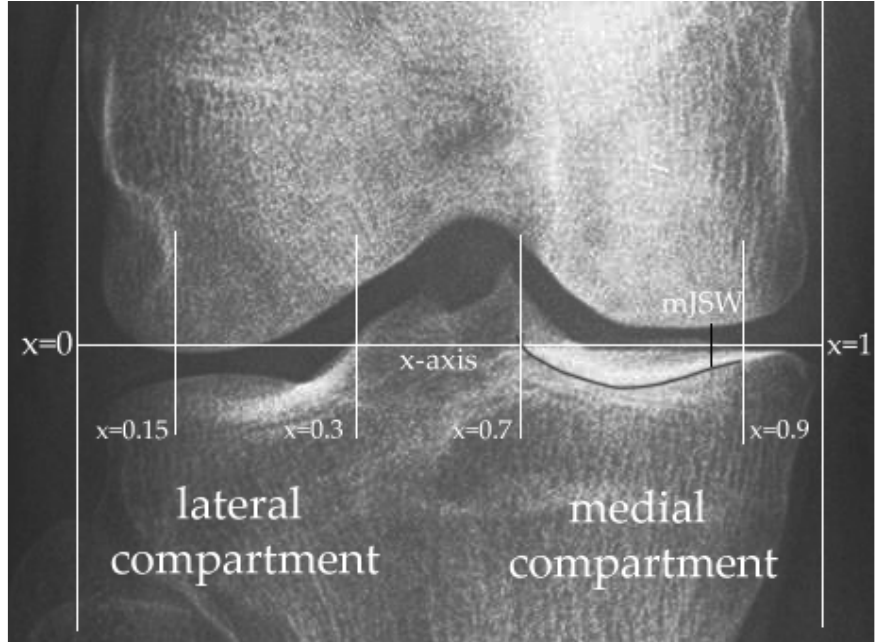
Figure 2. The definition of minimum-joint space width.